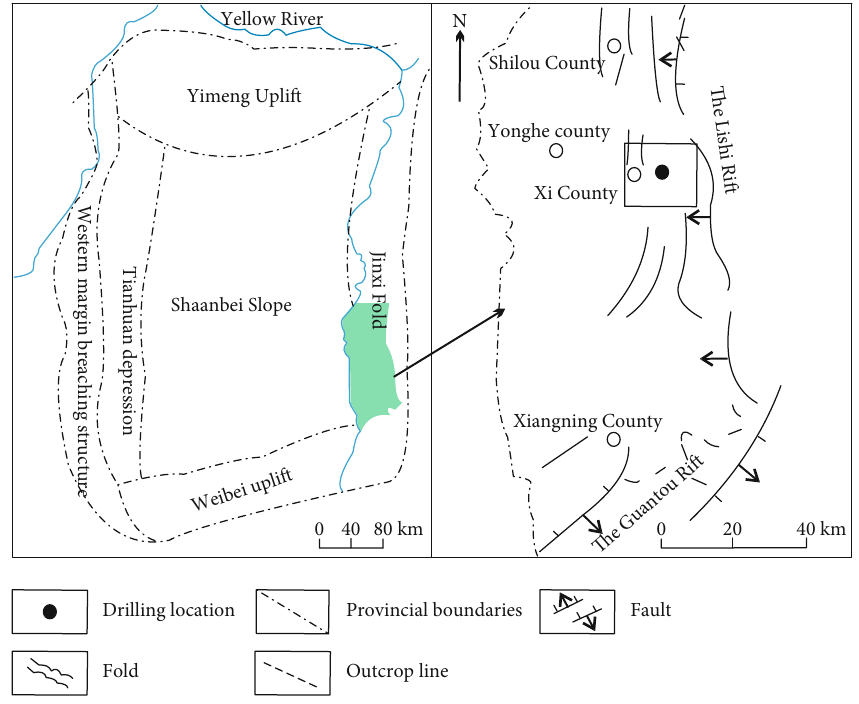
Figure 1: The structural diagram of the study area [19] and the location map of sampling